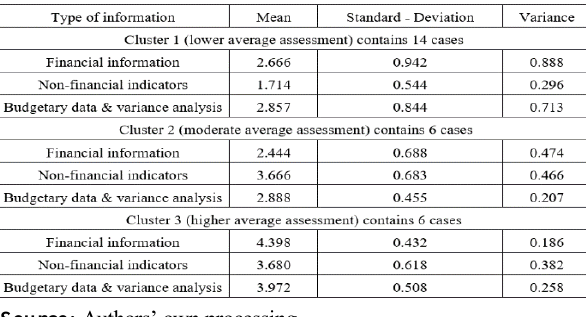
Table 4: The assessed suitability of selected